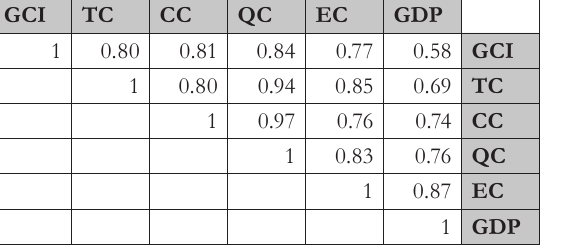
Tab. 5 – Correlation matrix of the GDP and tie indicators of competitiveness. Source: authors’